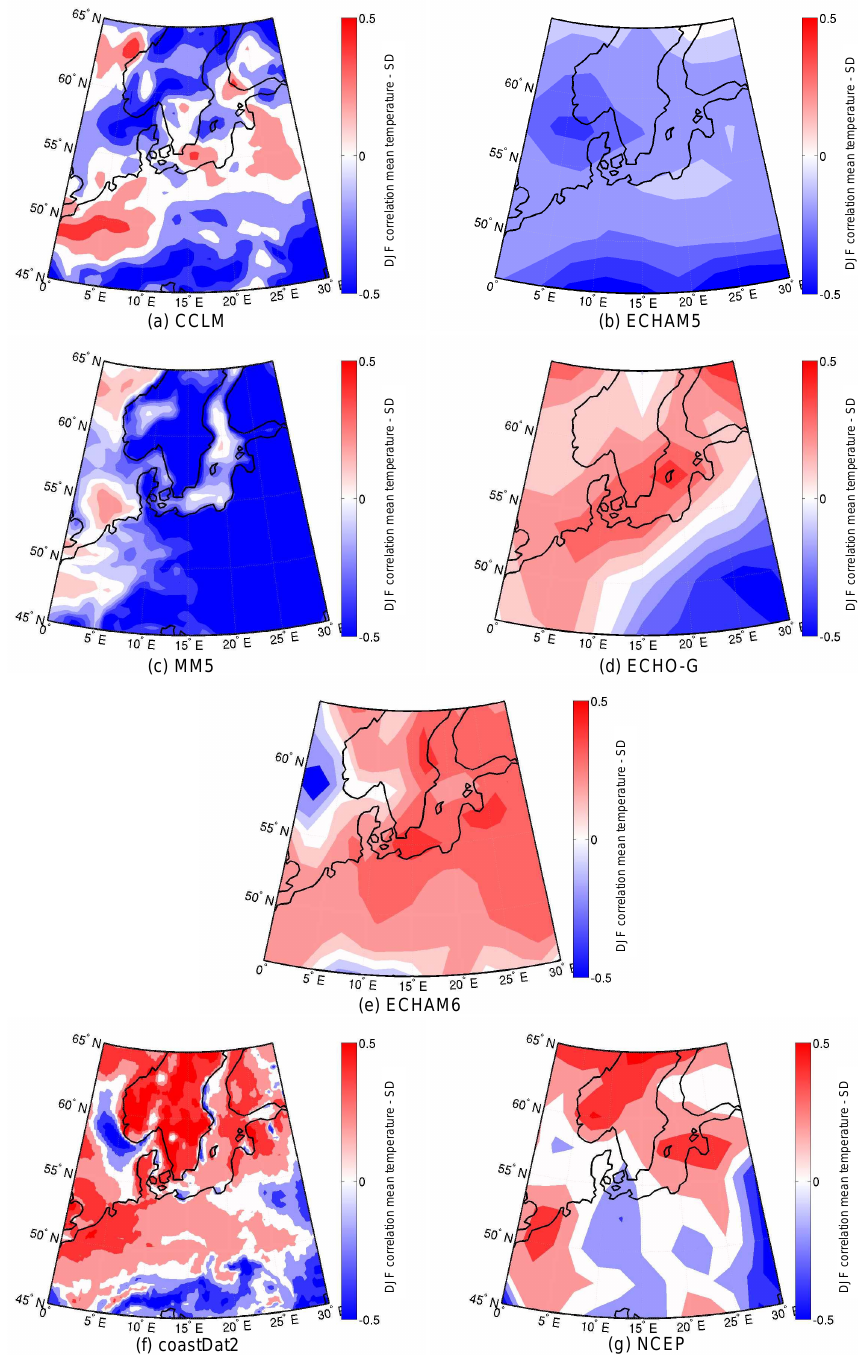
Figure 4. Correlation between field mean temperature and standard deviation of wind speed for seven different data sets: (a) CCLM (1655– 1999 AD), (b) ECHAM5 (850–2005 AD), (c) MM5 (1001–1990 AD), (d) ECHO-G (1001–1990 AD), (e) ECHAM6 (850–2005 AD), (f) coastDat2 (1948–2012 AD), (g) NCEP (1948–2012 AD).